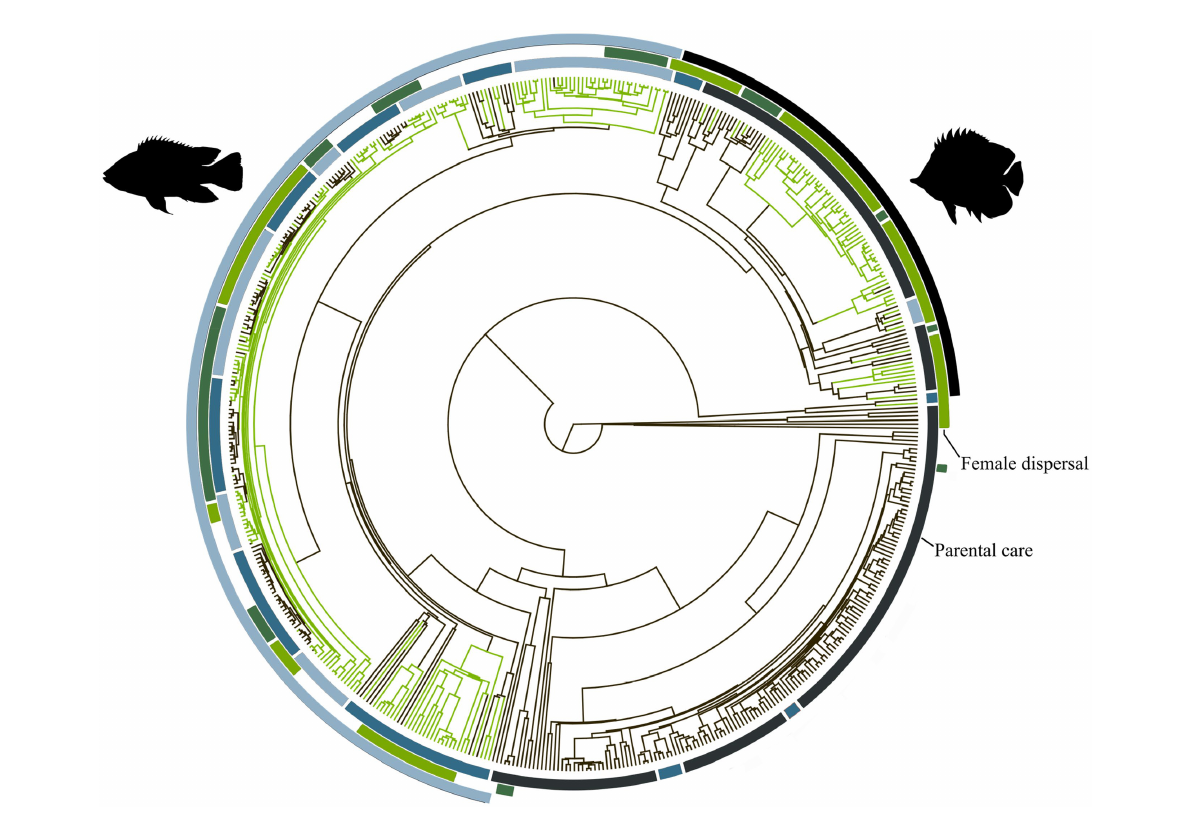
FIGURE 1 Phylogeny of the 546 fish species with known mating system analysed in this study. The branch colours correspond to mating system, where black = non-monogamous and green = monogamous. The inner band corresponds to parental care, where navy blue = no care, mid blue = uniparental care, and light blue = biparental care. The middle band corresponds to female dispersal, where dark green = multi-female groups and light green = dispersed females. The outer band shows the cichlids (left) and the marine reef fishes (right). Images are from PhyloPic.org. The cichlid image is courtesy of C. Julian under a creative commons attribution 3.0 unported licence